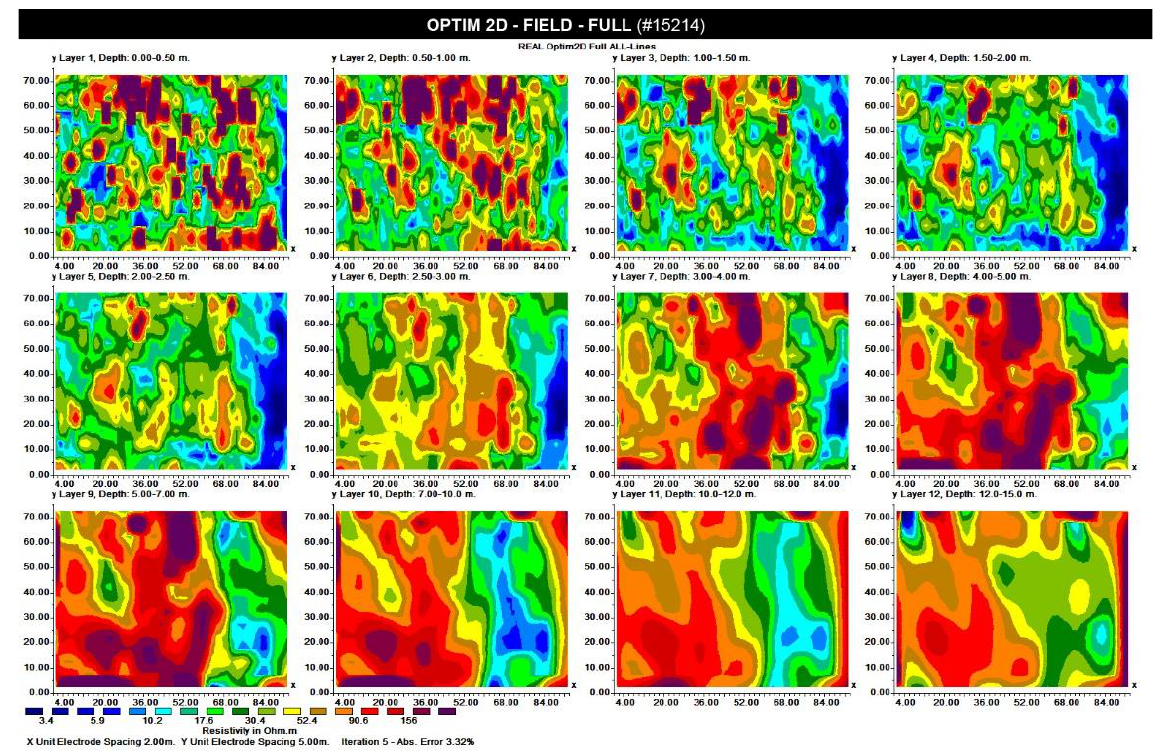
Figure 14. Inversion results from the Optim-2D field data set.